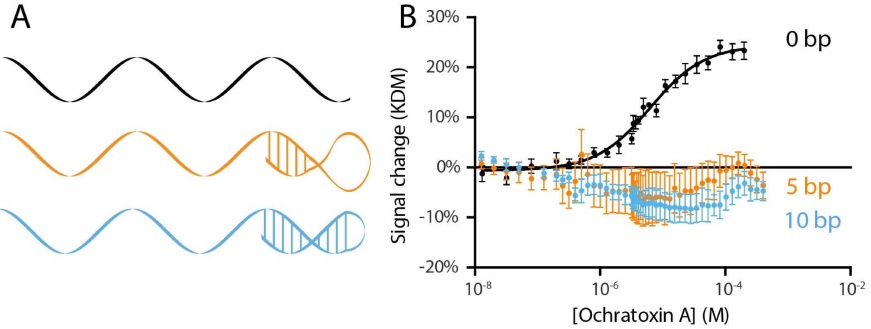
Figure 2. ( A ) To identify the E-AB sensor with the highest gain we explored the simplest linear aptamer sequence and two variants to which we added self-complementary tails. ( B ) Constructs with 5 and 10 self-complementary bases added to the 3 (cid:48) end of the aptamer (orange and light blue) do not, however, exhibit any significant change in signal upon target addition. An aptamer lacking any self-complementary tail (black), in contrast, exhibits the expected binding curve. Error bars shown are standard error of the mean for four (no tail) or two (5 bp, 10 bp tail) independently-fabricated